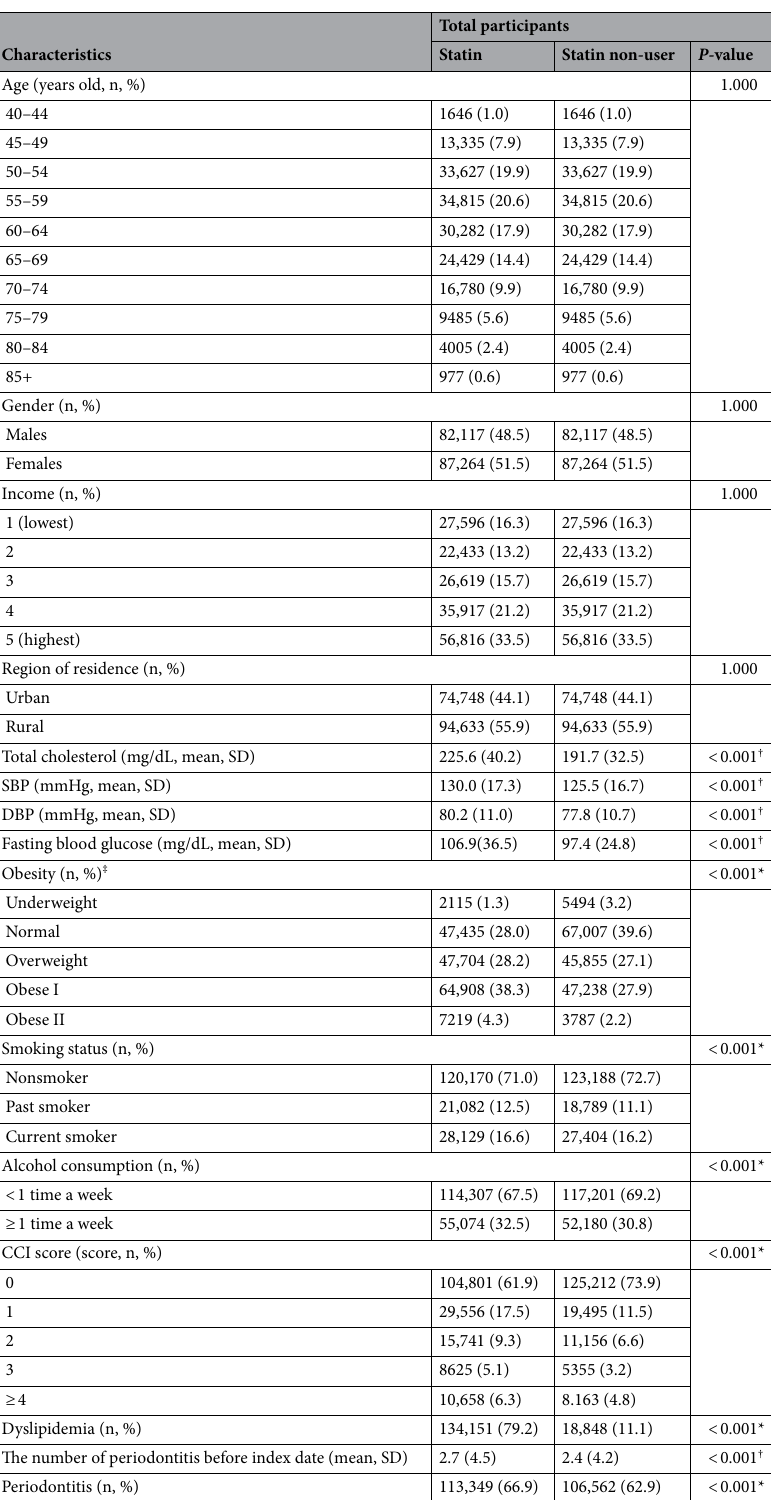
Table 1. General characteristics of participants between statin and control groups. SBP systolic blood pressure, DBP diastolic blood pressure, CCI Charlson comorbidity index, SD standard deviation.